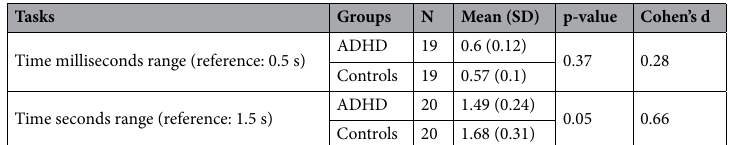
Tasks Groups N Mean (SD) p-value Cohen’s d Time milliseconds range (reference: 0.5